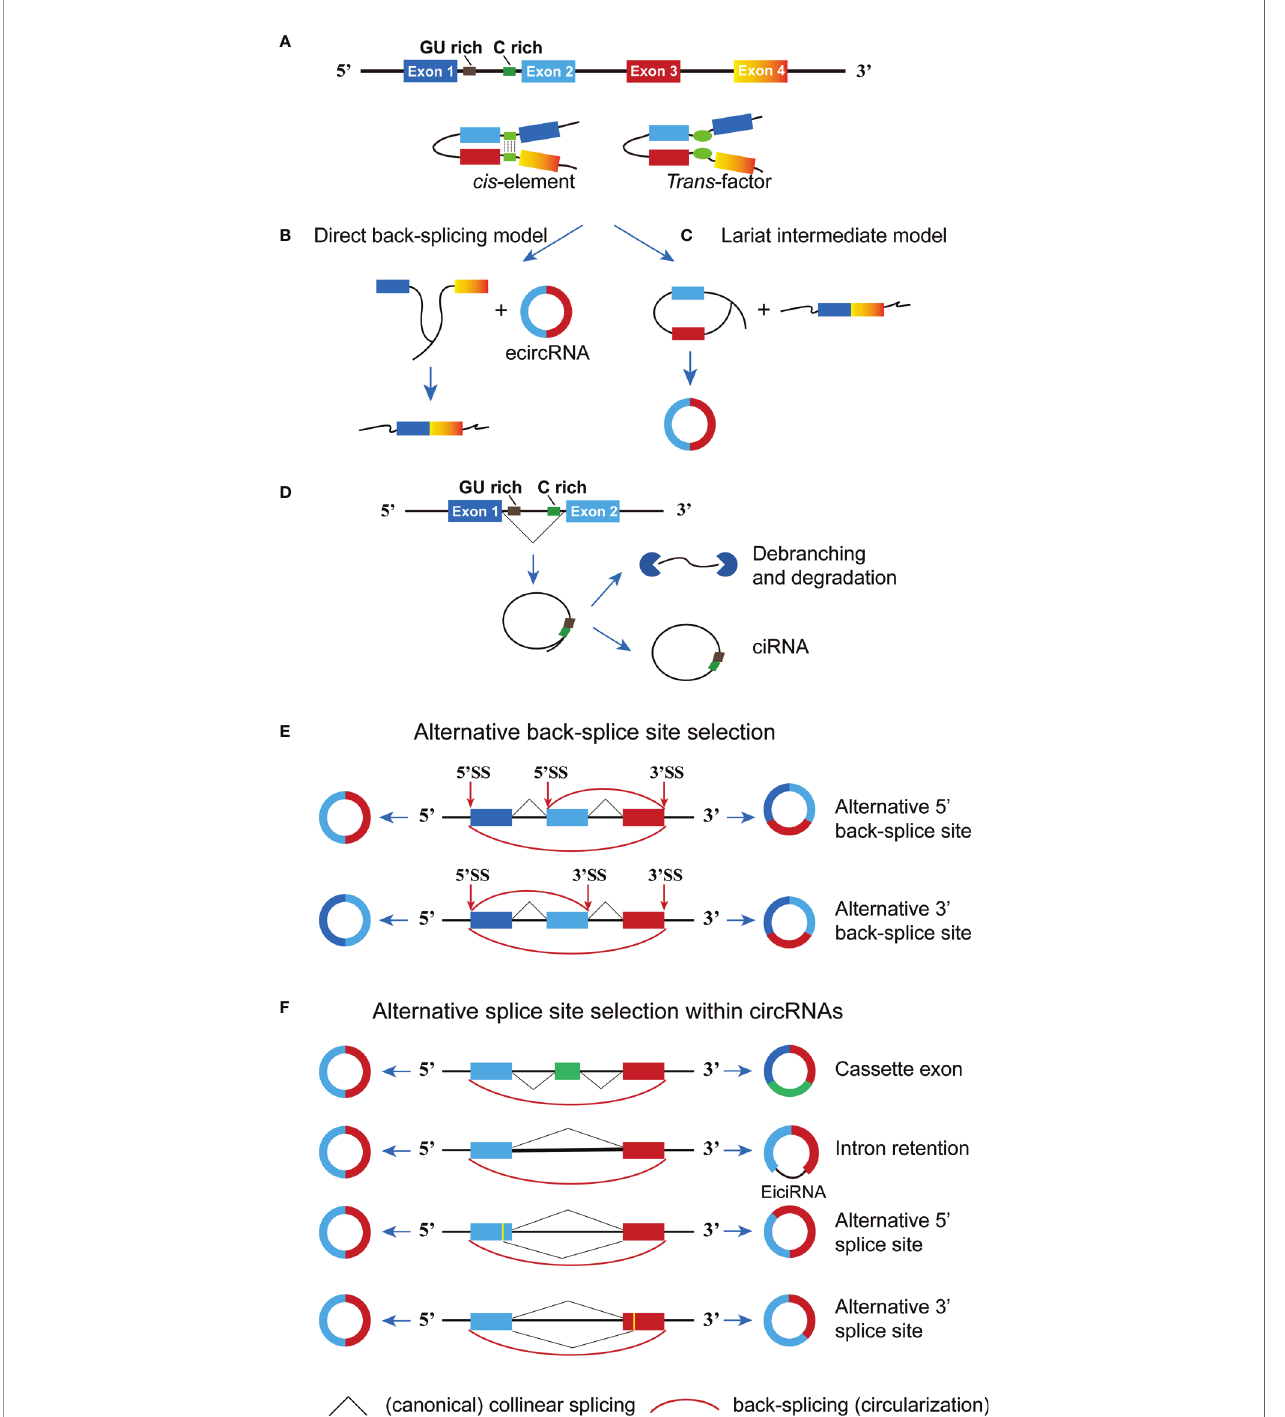
FIGURE 1 | The formation of circRNA. (A) The cis sequence and trans factor located in the intron region causes the intron region to pair and promote circRNA generation. (B) In the direct back-splicing model, back-splicing occurs fi rst and circRNA along with an exon-intron lariat intermediate is produced, the latter is further spliced to form linear RNA. (C) In the lariat intermediate model, splicing event occurs fi rst and linear RNA is generated, followed by a long intron containing exons for later back-splicing to form circRNA. (D) The conserved sequences (GU rich and C rich elements) at both ends of the intron help the intron avoid being hydrolyzed by the lasso debranching enzyme to form ciRNA structures. (E) Two types of alternative back-splicing. (F) Schematic diagrams of four basic types of alternative splicing. The pictorial representation is not to